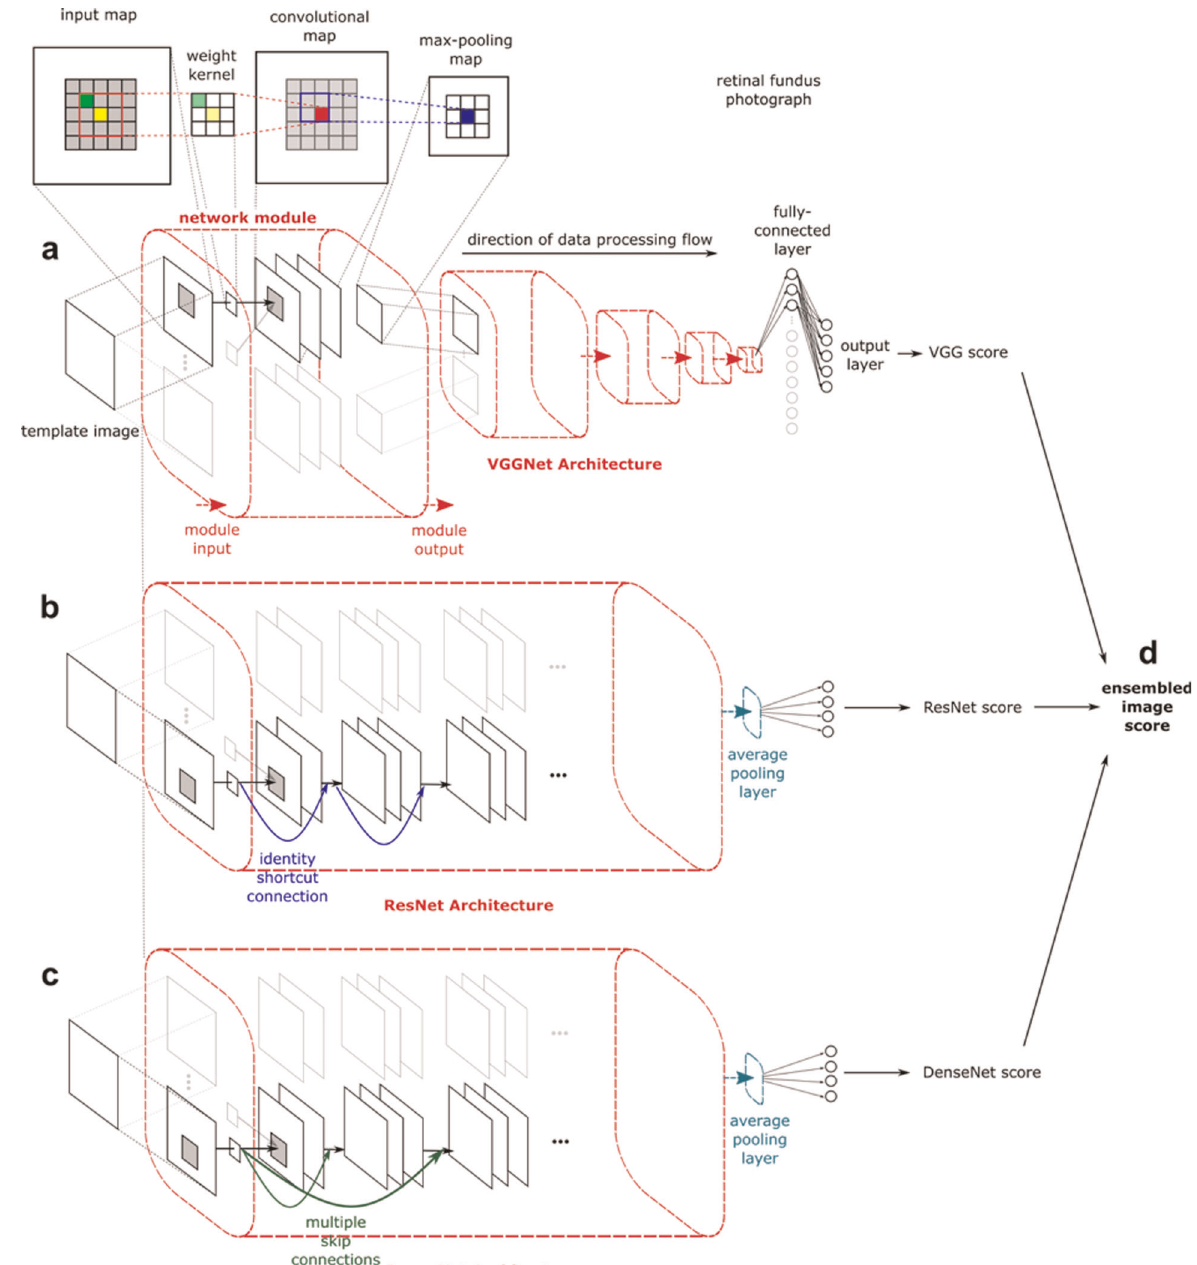
Fig. 4 Convolutional neural networks investigated. The architecture of convolutional neural networks (CNNs) are based on few general principles. The network is composed of mathematically weighted neurons that form sequential layers where there is linear transfer of signal from the input through to the output layers. For this study, each input image was pre-processed by scaling to a fi xed template of 512 × 512 pixels in resolution. These images were subsequently represented as a matrix of Red Green Blue (RGB) values in the input layer. Sequential convolutions were conducted by superimposing a weighted kernel over these input maps, with our study using a 3 × 3 weighted kernel with subsequent max-pooling. The output layer utilizes a softmax classi fi er to generate probability values for the pre-de fi ned output classes 15,32,52 . a VGGNet is the oldest CNN used in this comparison, released in 2014. Despite its standard uniform architecture composed of 16 layers, it has had great success at feature extraction 53 . b ResNet has been highly favored since its introduction in 2015, with its atypical architecture utilizing skip residual connections (visualized as blue arrows) to bypass signals across layers. This allows for increase in layers without compromising the ease of training, resulting in supra-human performance of 3.6% top-5 error rate 54 . c DenseNet is a newer CNN released in 2017 that has been shown to perform better than ResNet. Its architecture builds on a similar principle to the one capitalized by ResNet, but rather has a dense connectivity pattern where each layer receives information from all preceding layers as shown by the green arrows. This allows concatenation of sequential layers and compacting the network into a ‘ denser ’ con fi guration 40 . d Ensemble is a combination of the three networks ’ probability output scores generated per eye, through the acquisition of the mean